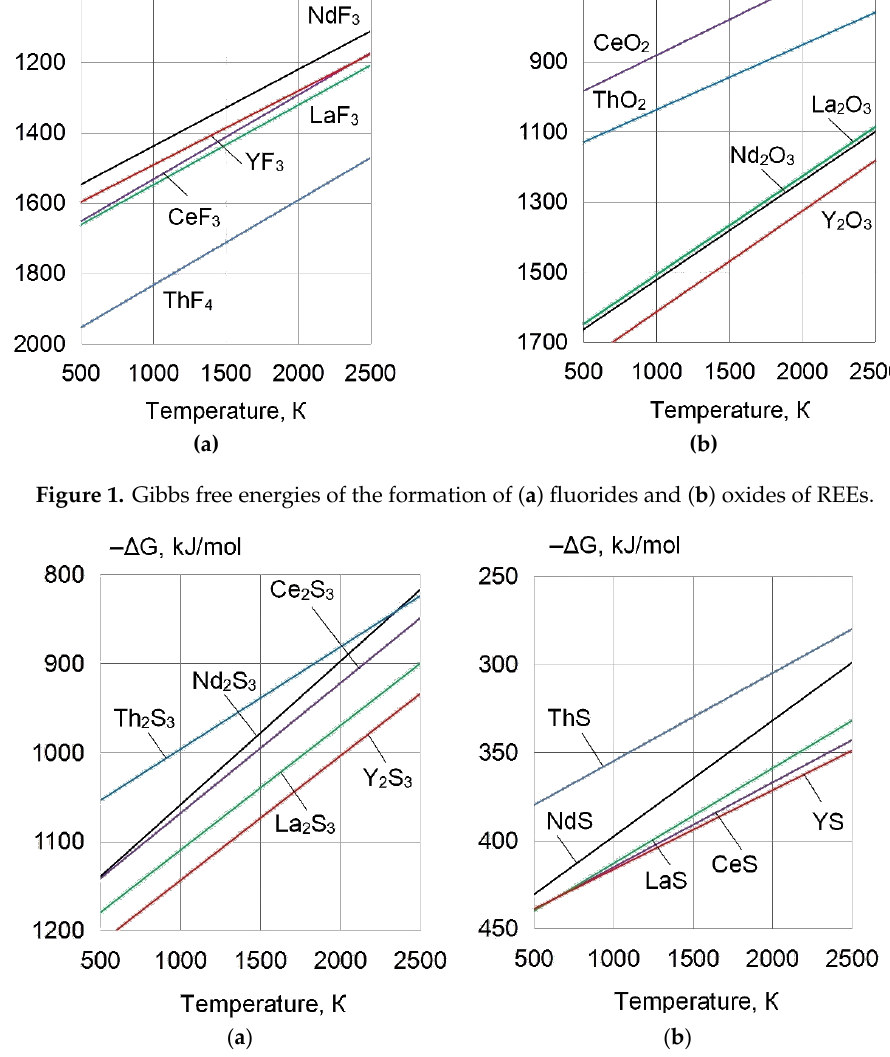
Figure 2. Gibbs free energies of the formation of ( a , b ) sulphides of REEs.